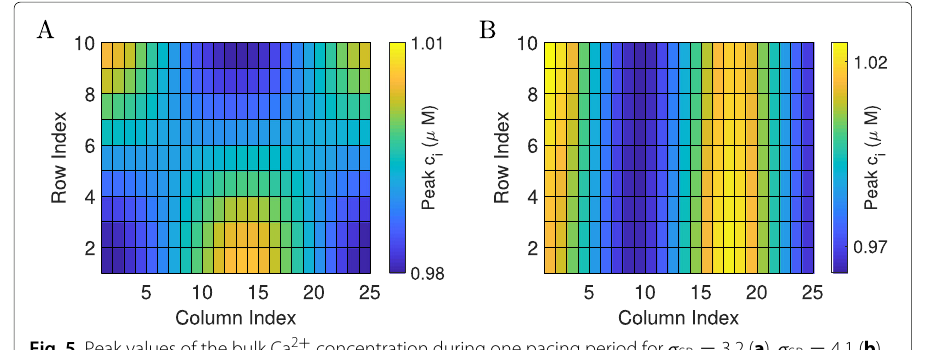
Fig. 5 Peak values of the bulk Ca 2 + concentration during one pacing period for σ SR = 3.2 ( a ), σ SR = 4.1 ( b ) in a 10 × 25 network of CRUs at T p =